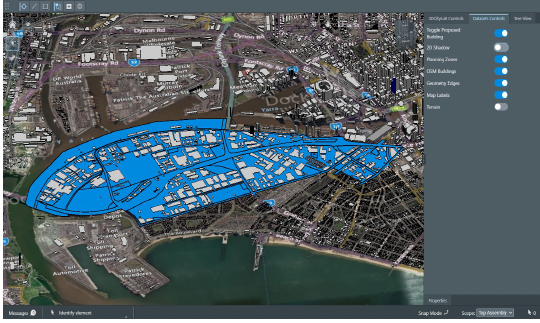
Figure 6 . Added datasets in